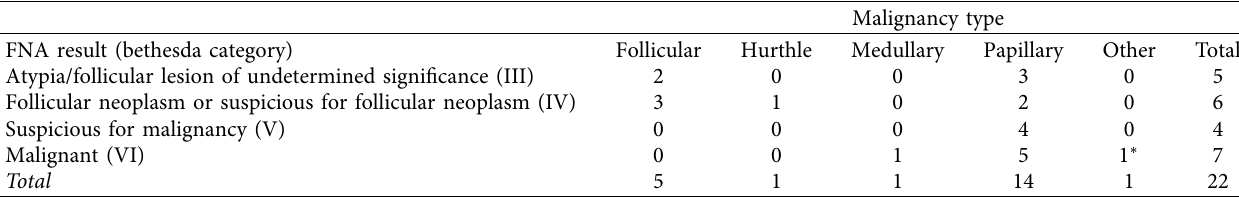
Table 3: Type of malignancy on final surgical pathology by FNA result ( n � 22).